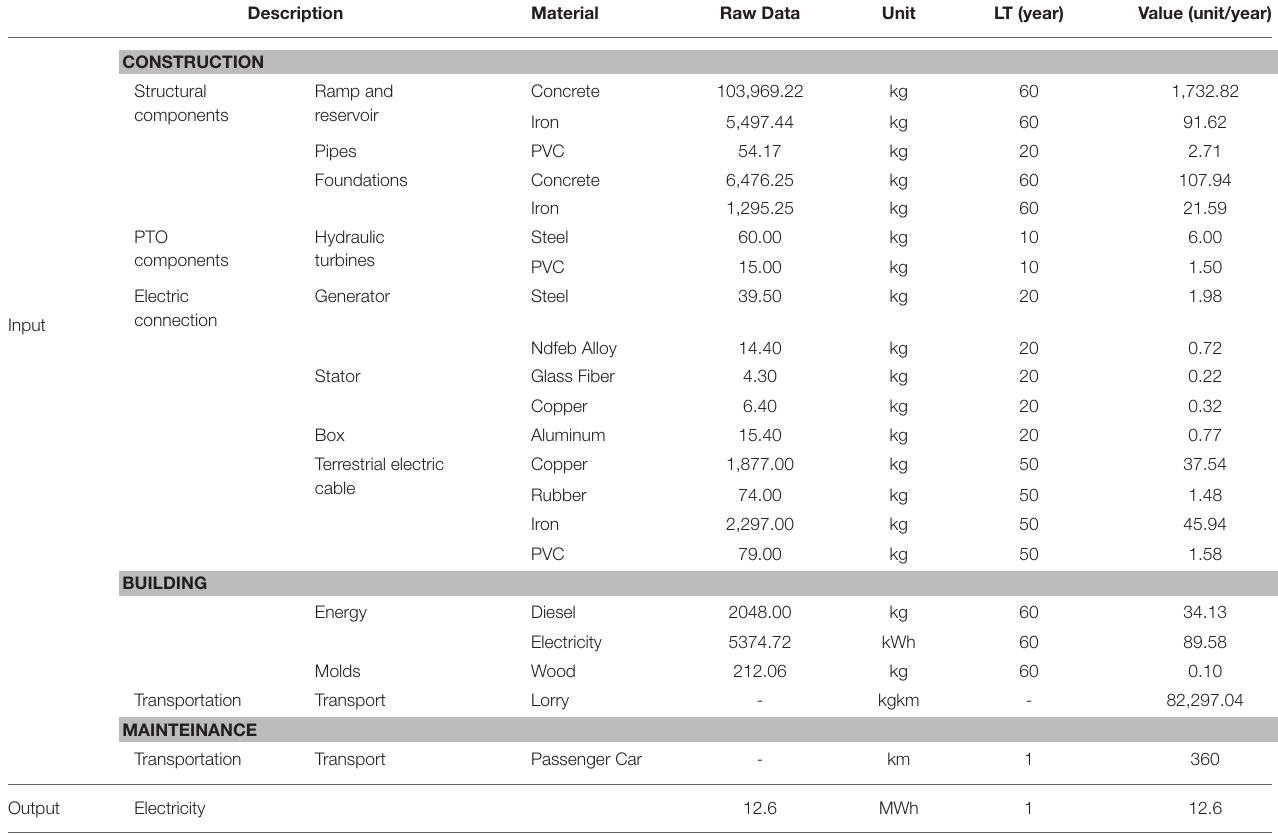
TABLE 2 | Life Cycle Inventory for the production of the functional unit (i.e., the OBREC